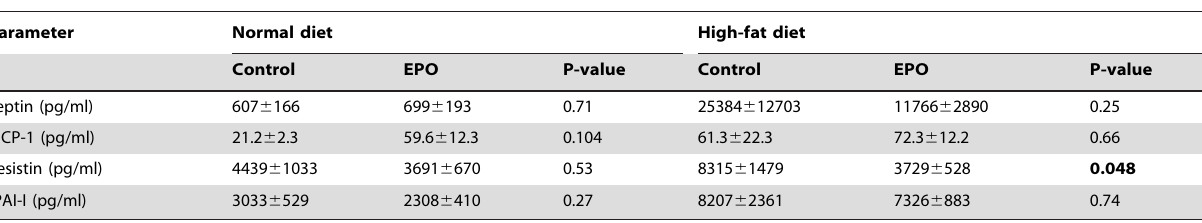
Table 1. Serum levels of metabolic hormones.